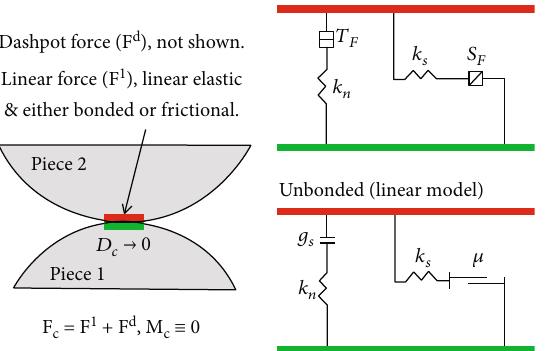
Figure 4: Linear contact bond model (from PFC5.0). F is distance between of particles. M c is contact moment. force. D c is tensile force. S is shear force. g T F F sti ff ness. k is shear sti ff ness. μ is friction coe ffi s